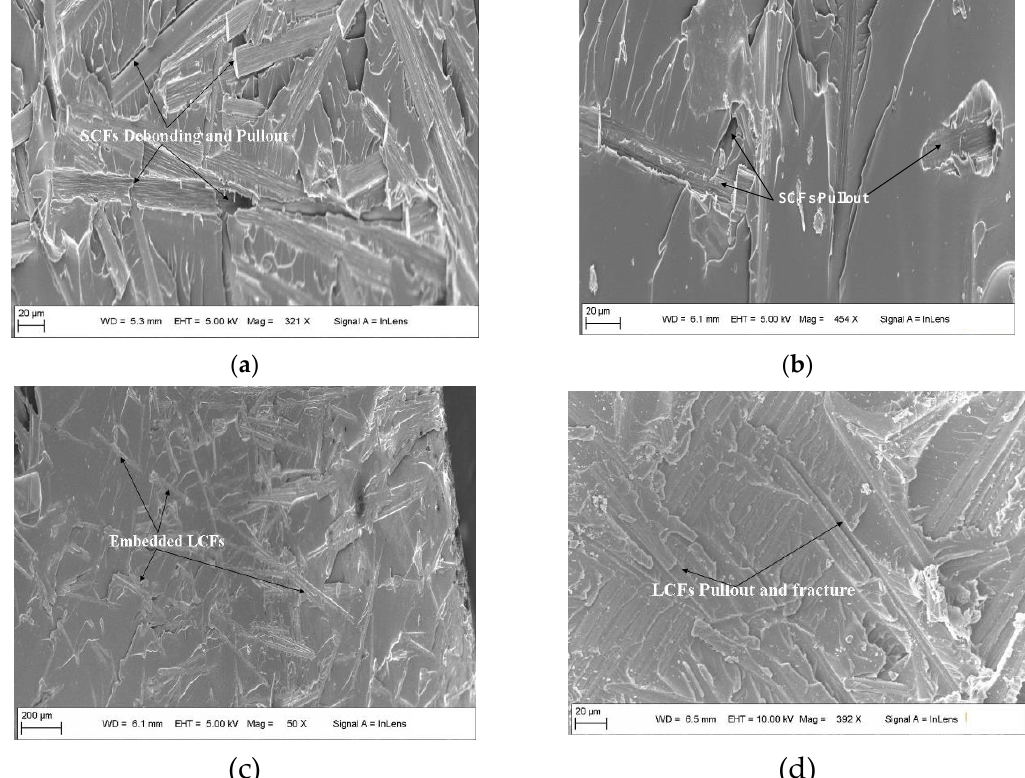
Figure 9. The fracture surface morphology of the laminates interleaved with NWCT made of ( a , b ) SCFs for Mode I, ( c ) LCFs for Mode I and ( d ) LCFs for Mode II .